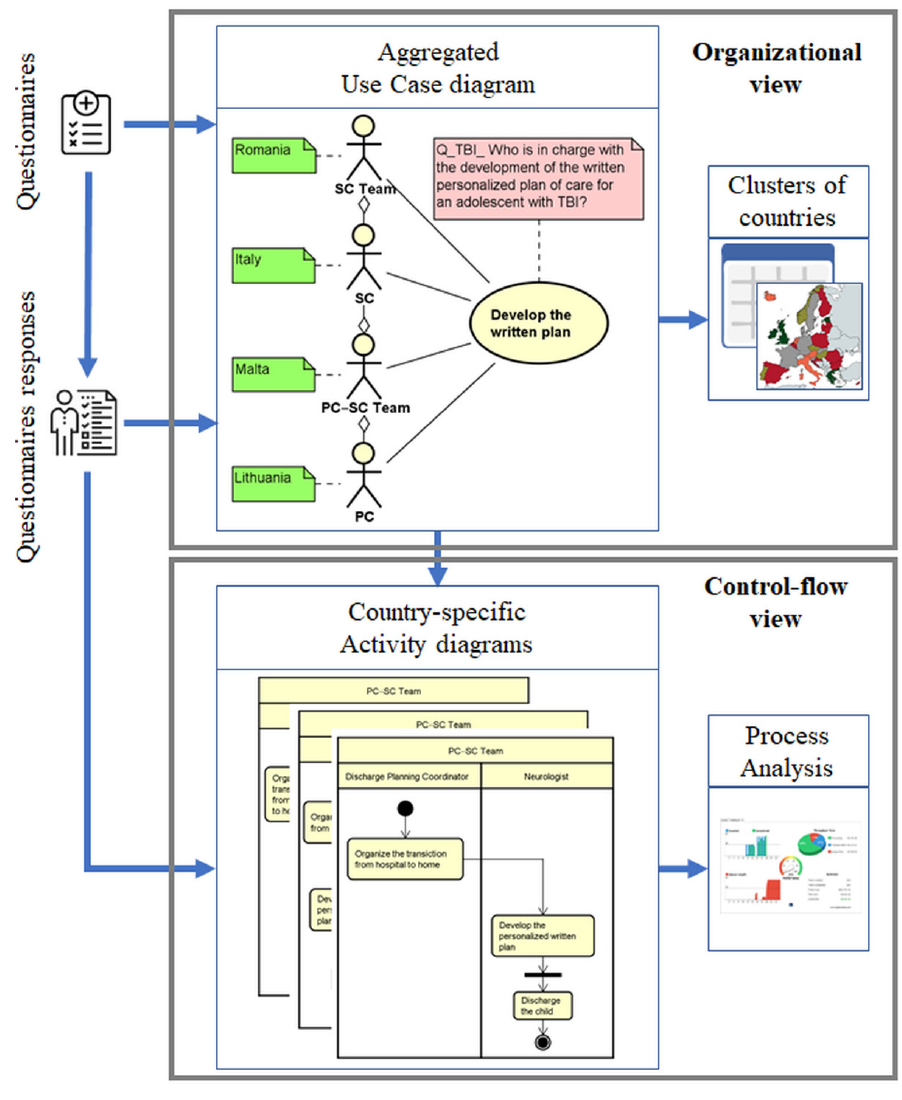
Figure 2. Steps of the methodology highlighting the input, the UML diagrams, and the analysis performed in the organization and in the control-flow views. performed in the organization and in the control-flow